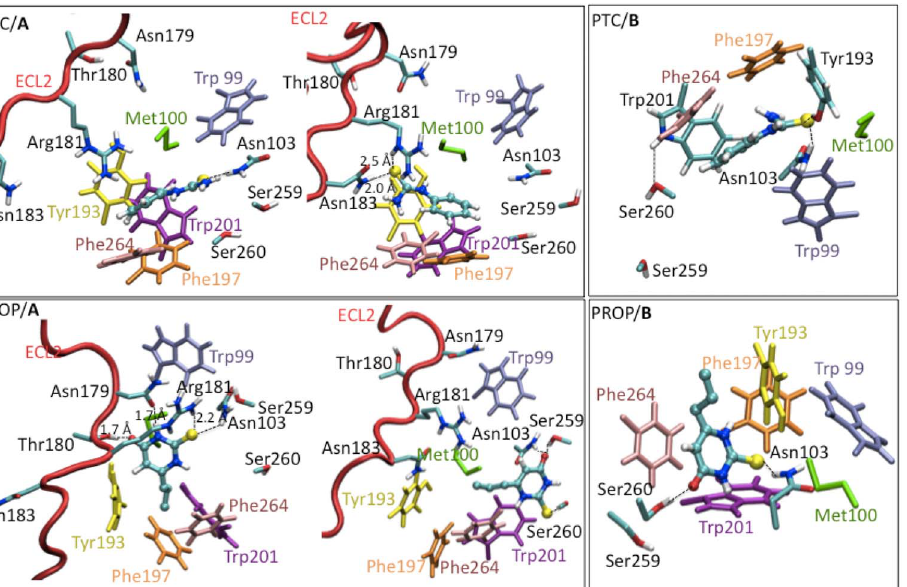
Figure 3. Central structures of PTC/A - PROP/A and PTC/B - PROP/B main clusters emerging from our MM/CG simulations. Residues forming mostly or exclusively hydrophobic contacts with the agonists (Met100, Phe264, Phe197, Trp99, Trp201, Tyr193) are colored in green, pink, orange, light violet, purple, yellow, respectively. The agonists are shown in ball-and-sticks representation and they are colored by atom type. The ECL2 loop interacts with the binding site only in the A complexes. It is shown in red cartoon. Selected distances for Asn179, Thr180, Arg181 and Asn183 residues in the ECL2 loop are shown for PTC/A and PROP/A. doi:10.1371/journal.pone.0064675.g003 PLOS ONE |